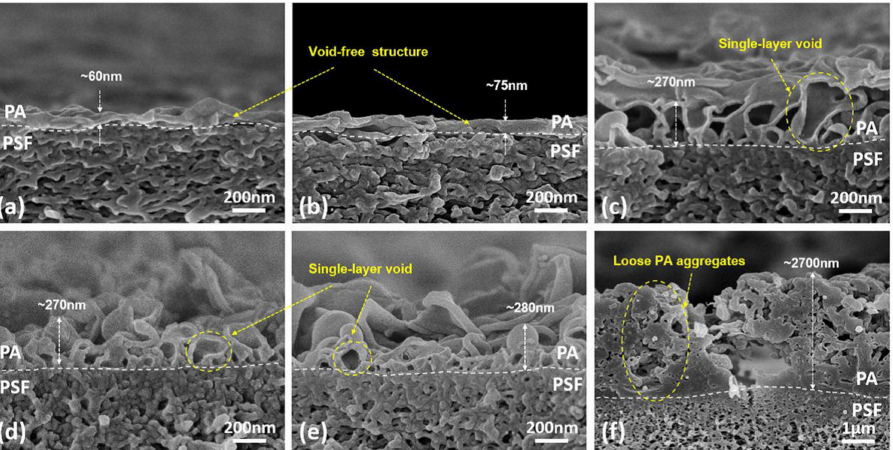
Figure 4. Scanning electron microscopy (SEM) images of the cross-section of the TFC